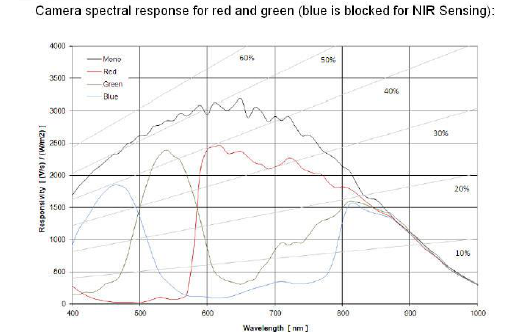
Figure 11. Spectral camera response for red and green